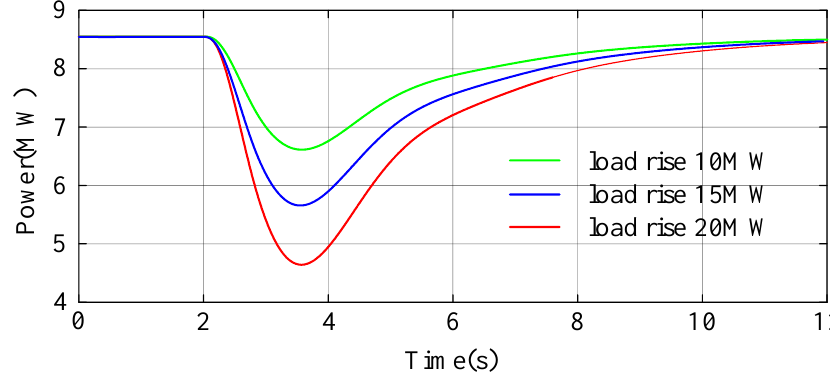
Figure 20. Operation curve of P2H at medium wind speed.